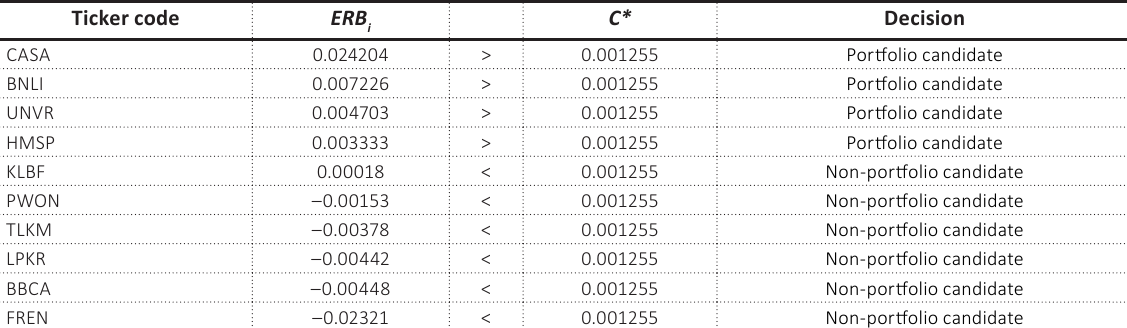
Table 5. Determination of the candidate of the optimum portfolio, ERB > C *